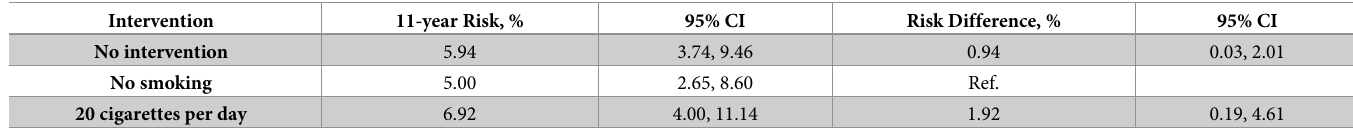
Table 2. Total effect of smoking 20 cigarettes per day compared to no smoking on CHD, using parametric g-formula in the Multi-Ethnic Study of Atherosclerosis, United States, 2000–2011. Intervention